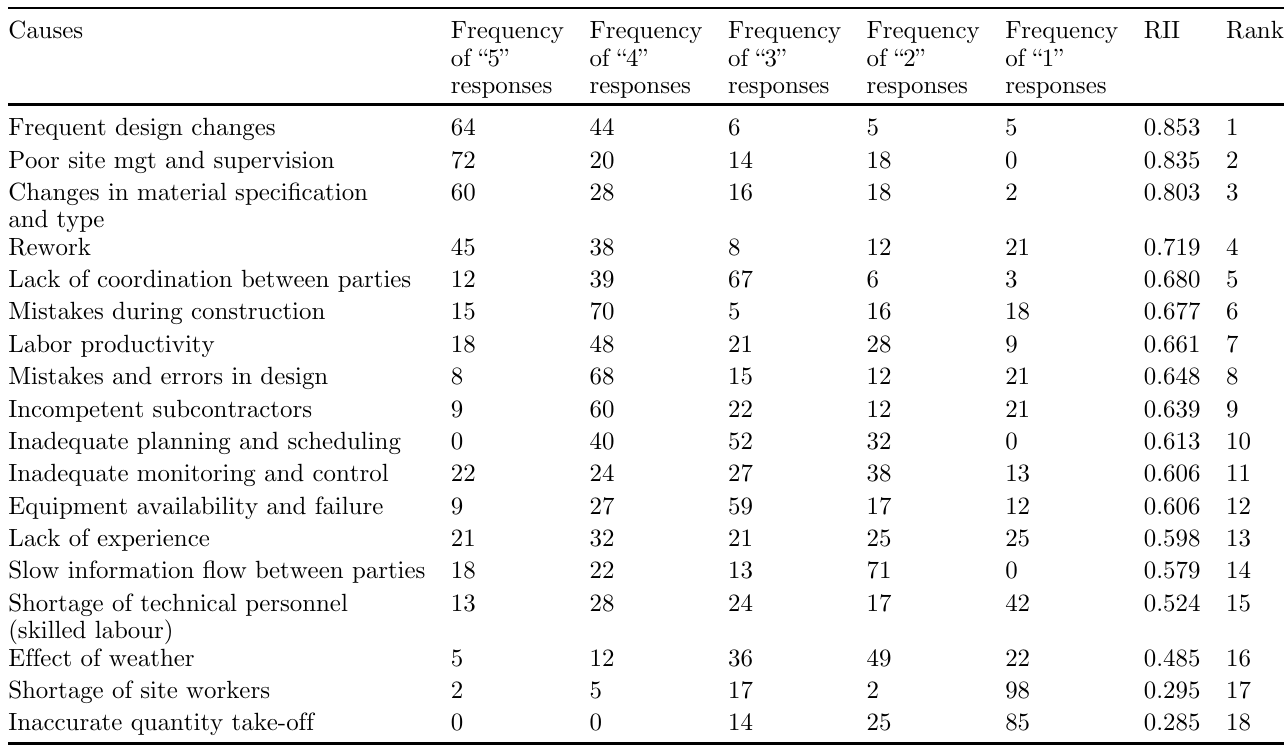
Table 3. RII and causes of waste.